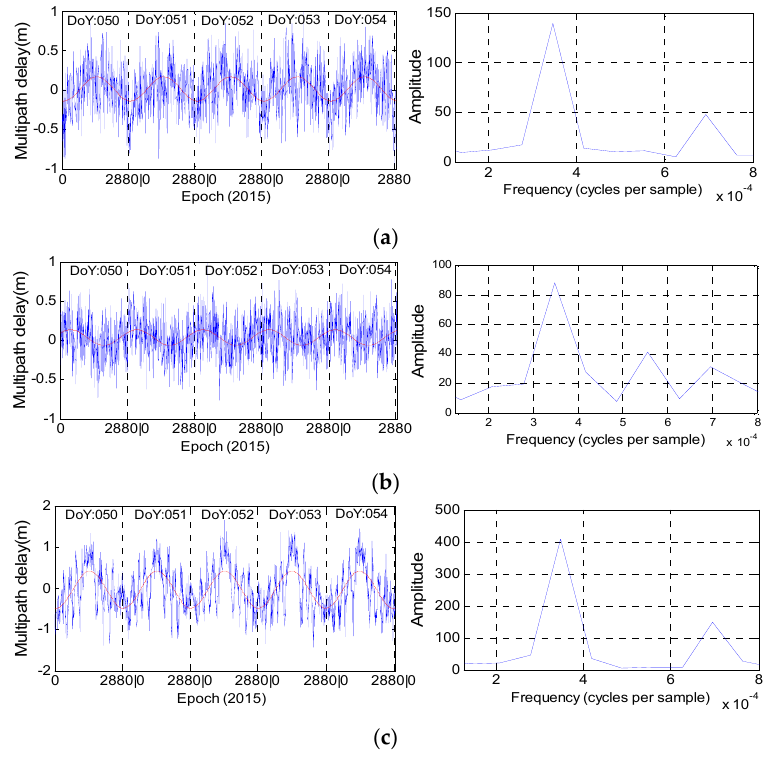
Figure 10. The fitted curve ( red line ) and its corresponding magnitude spectrum ( right ) for C01 ( a ); C02 ( b ) and C04 ( c ) at station CUT0.